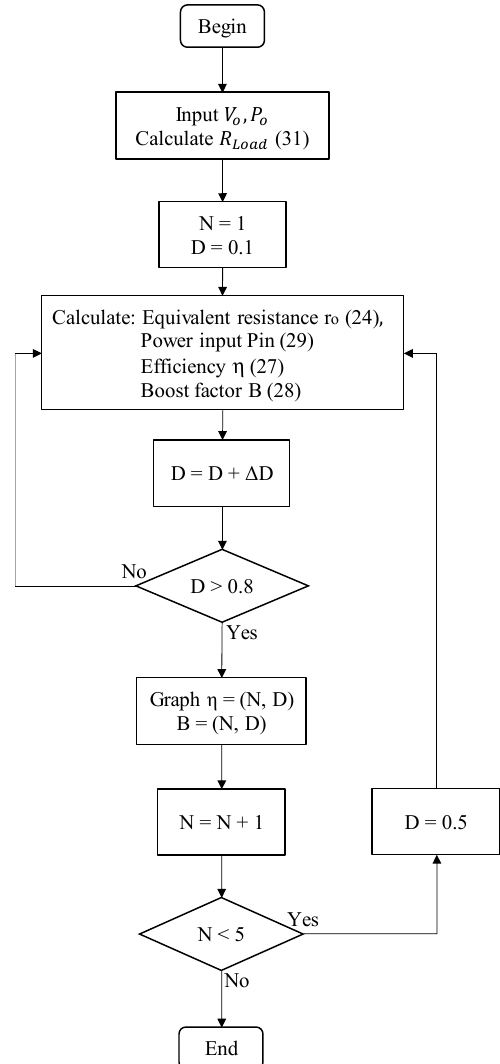
Figure 5. Plotting flowchart of η and B form N and D .